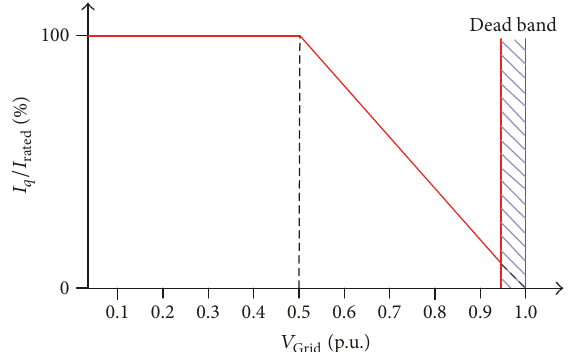
Figure 11: German and Danish grid code reactive current require- ments during sags